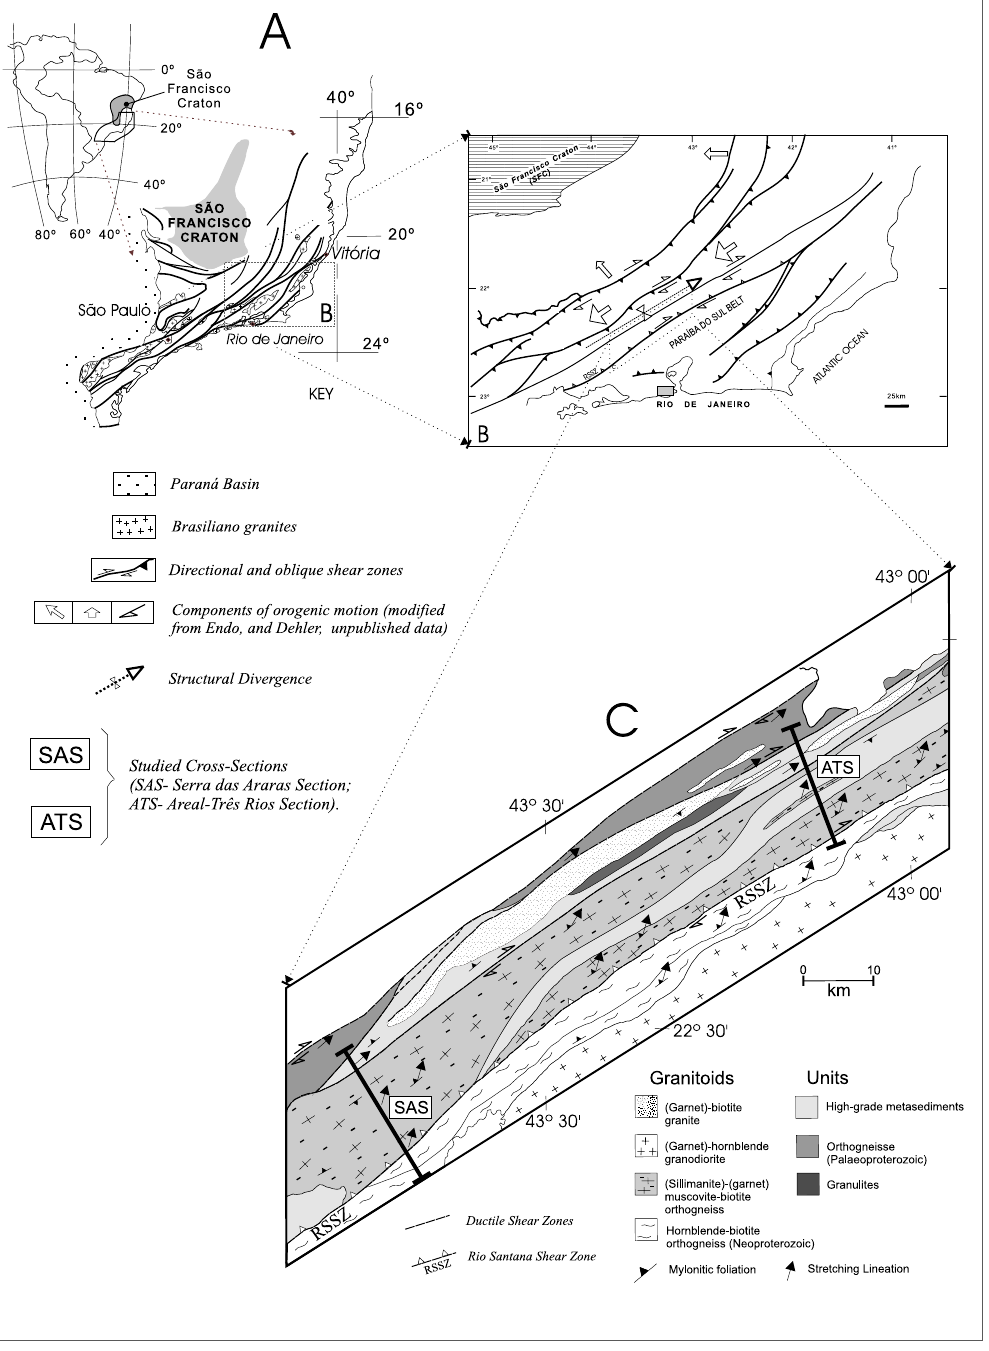
Fig. 1 – Map of the Mantiqueira Province (A), regional shear zone pattern in the Paraíba do Sul Belt, southeastern São Francisco Craton (B), and the southern limb of the regional fan-like structure (C). The tectonic situation and the regional lithostructural map of the southern limb of the divergence is also shown in b and c respectively. See text for further discussion (modified from N.M. Dehler, unpublished